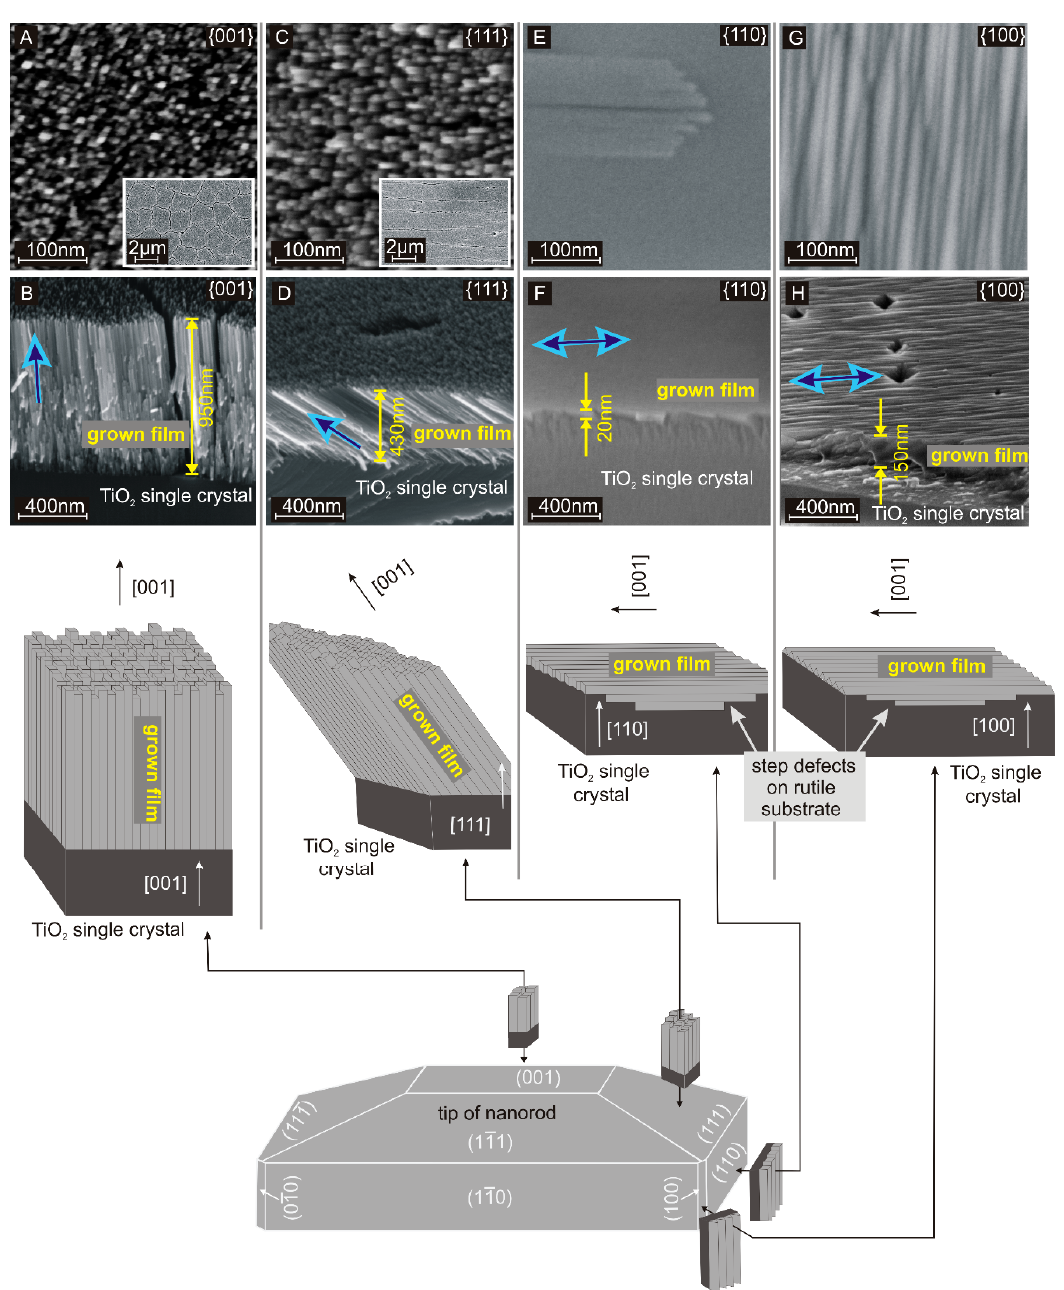
Figure 1. Top view ( A,C,E,G ) and cross-section ( B,D,F,H ) SEM images of hydrothermally grown TiO 2 structures on rutile single crystals with {001}, {111}, {110}, and {100} facets. The schematic drawing makes up a relationship between these structures and the observed facets on a common rutile TiO 2 nanorod: Growth on facets perpendicular to the {001} facet is expected to be much less pronounced, which is in good agreement with the cross-section images. Growth on the {110} facet, which corresponds to the flat side walls of a nanorod results in a flat film. In contrast, growth on the {100} facet, which corresponds to the edges of a nanorod results in dense parallel gables. The principal growth direction ([001]) is marked with a blue arrow.